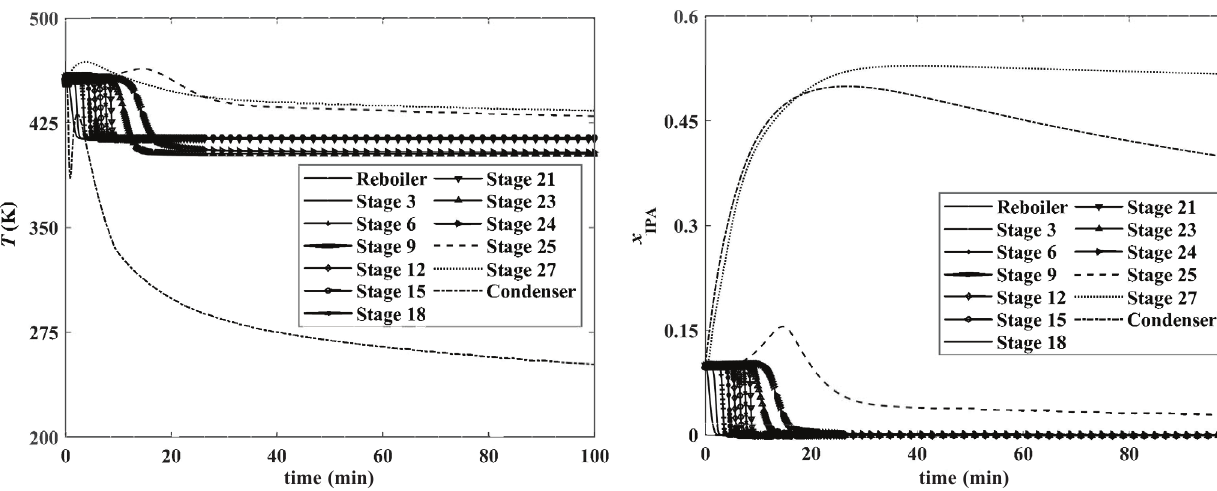
Fig. 4 – Temperature profiles of column stages with respect to time obtained for base case